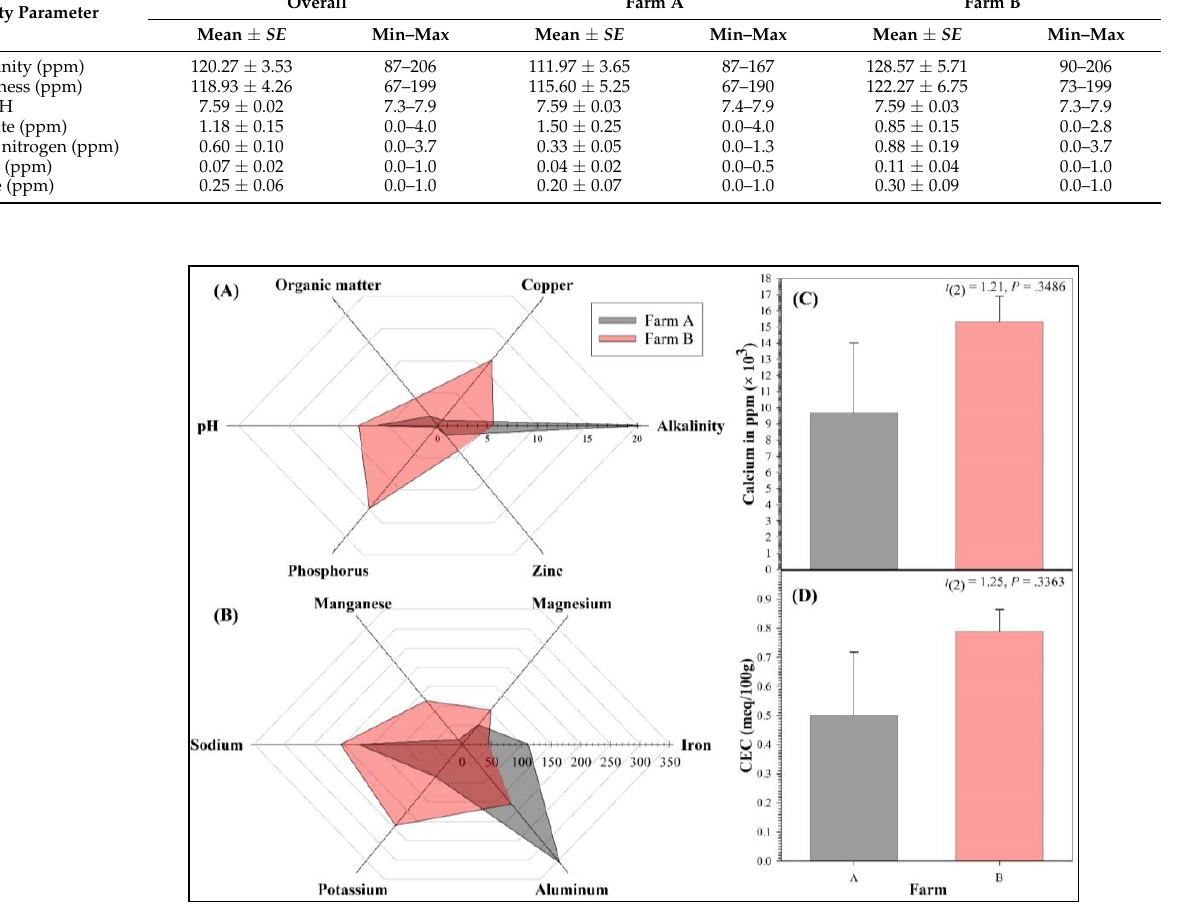
Figure 7. Radar plots ( A , B ) and bar charts ( C , D ) of sediment chemistry parameters measured in samples collected from 2 farms (2 ponds per farm). Error bars in bar charts represent the standard error of the mean. Table 3. Sediment chemistry parameters (mean, standard error ( SE ), minimum measurement (min), and maximum measurement (max)) measured in soil samples collected from 2 farms (2 ponds per farm), test statistics ( t ) and p -values of statistical comparison between farms, and the sample size ( n ) required to reveal statistically significant differences between farms.